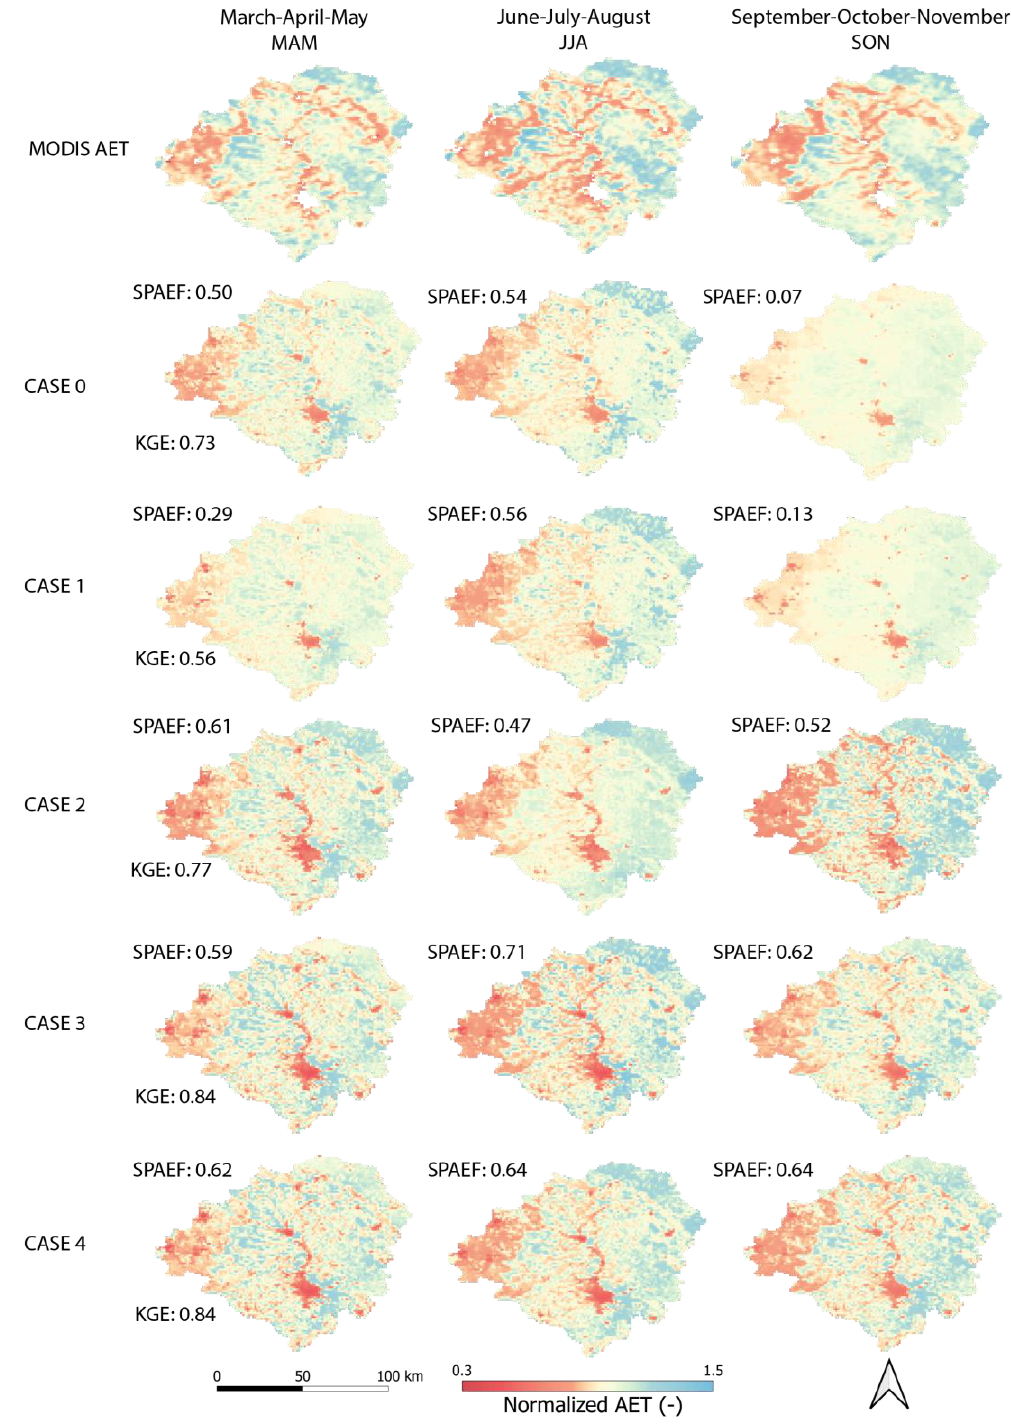
Figure 5. Spatial pattern results of average 3-month periods compared with observed MODIS AET.